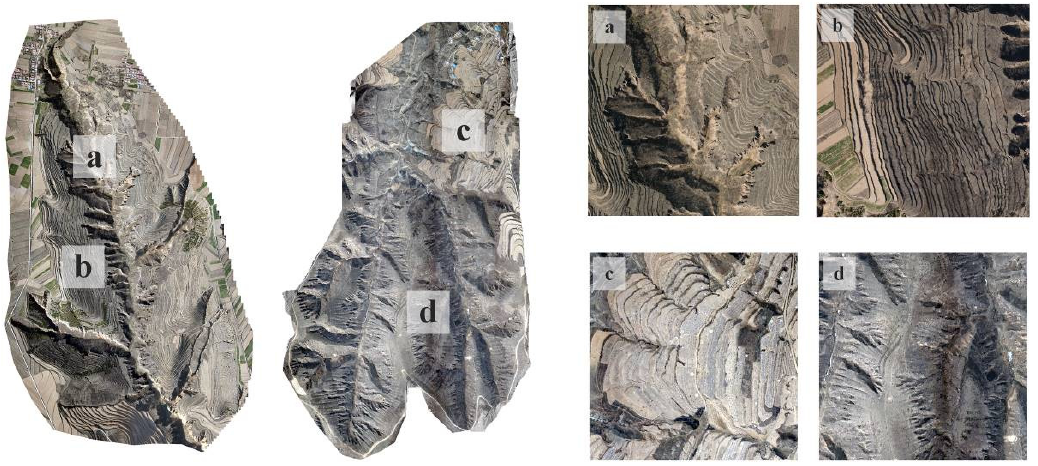
Figure 6. Ortho-mosaics for: Changwu ( left ); and Ansai ( right ).